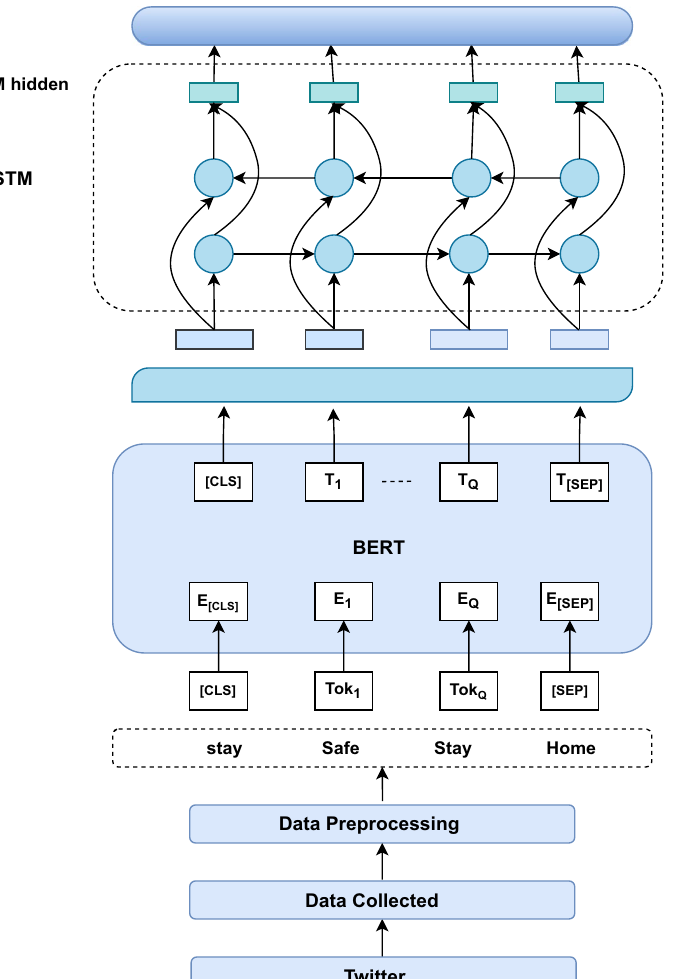
Figure 1. The architecture of BERT-Bi-LSTM Ensemble model for opinion